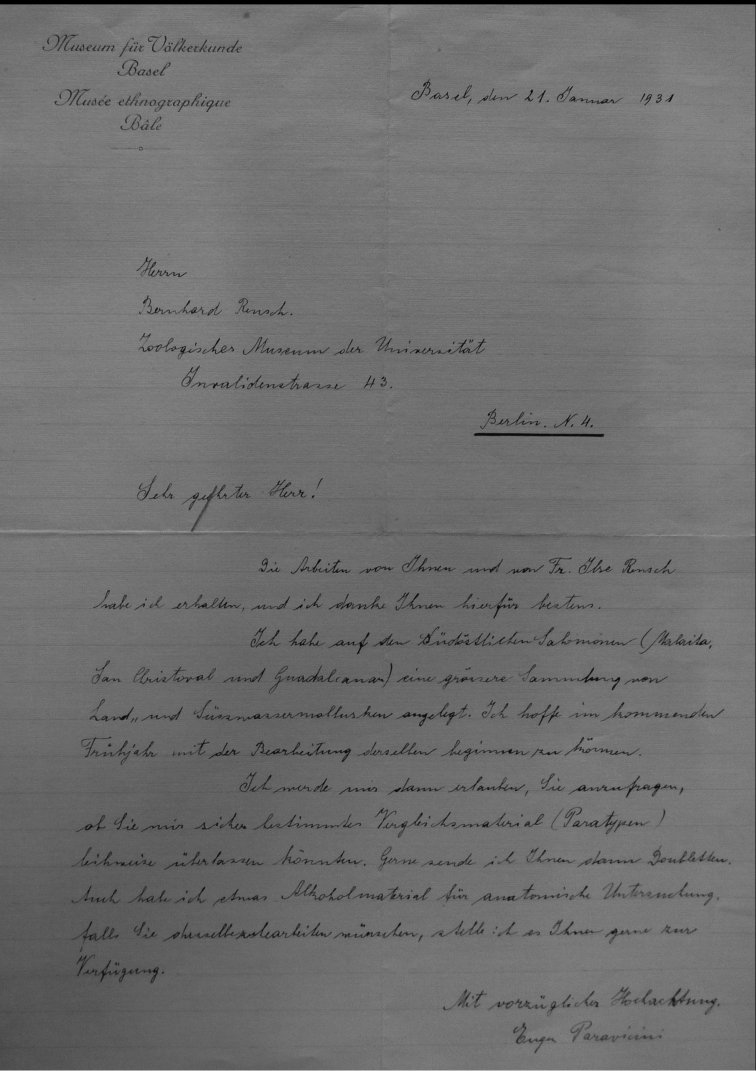
Letter of E. Paravicini to B. Rensch, Basel, 21.i.1931 (21 × 27.5 cm).